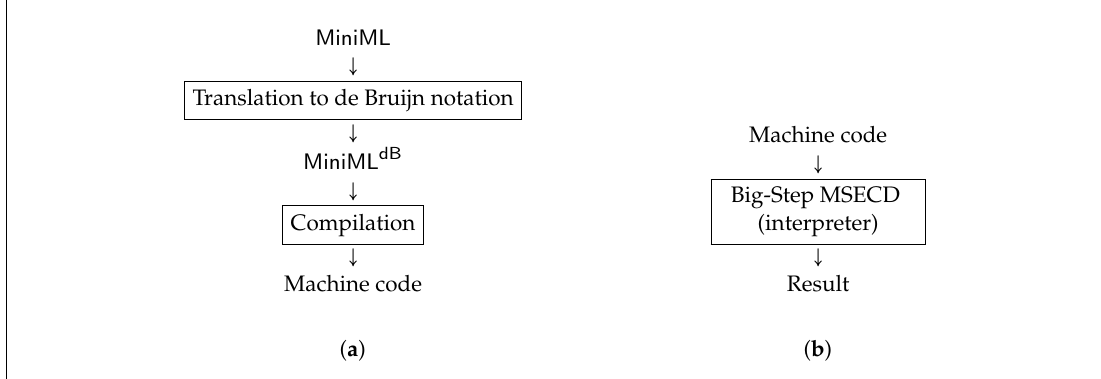
Figure 1. Compiler architecture. ( a ) Compilation; ( b )